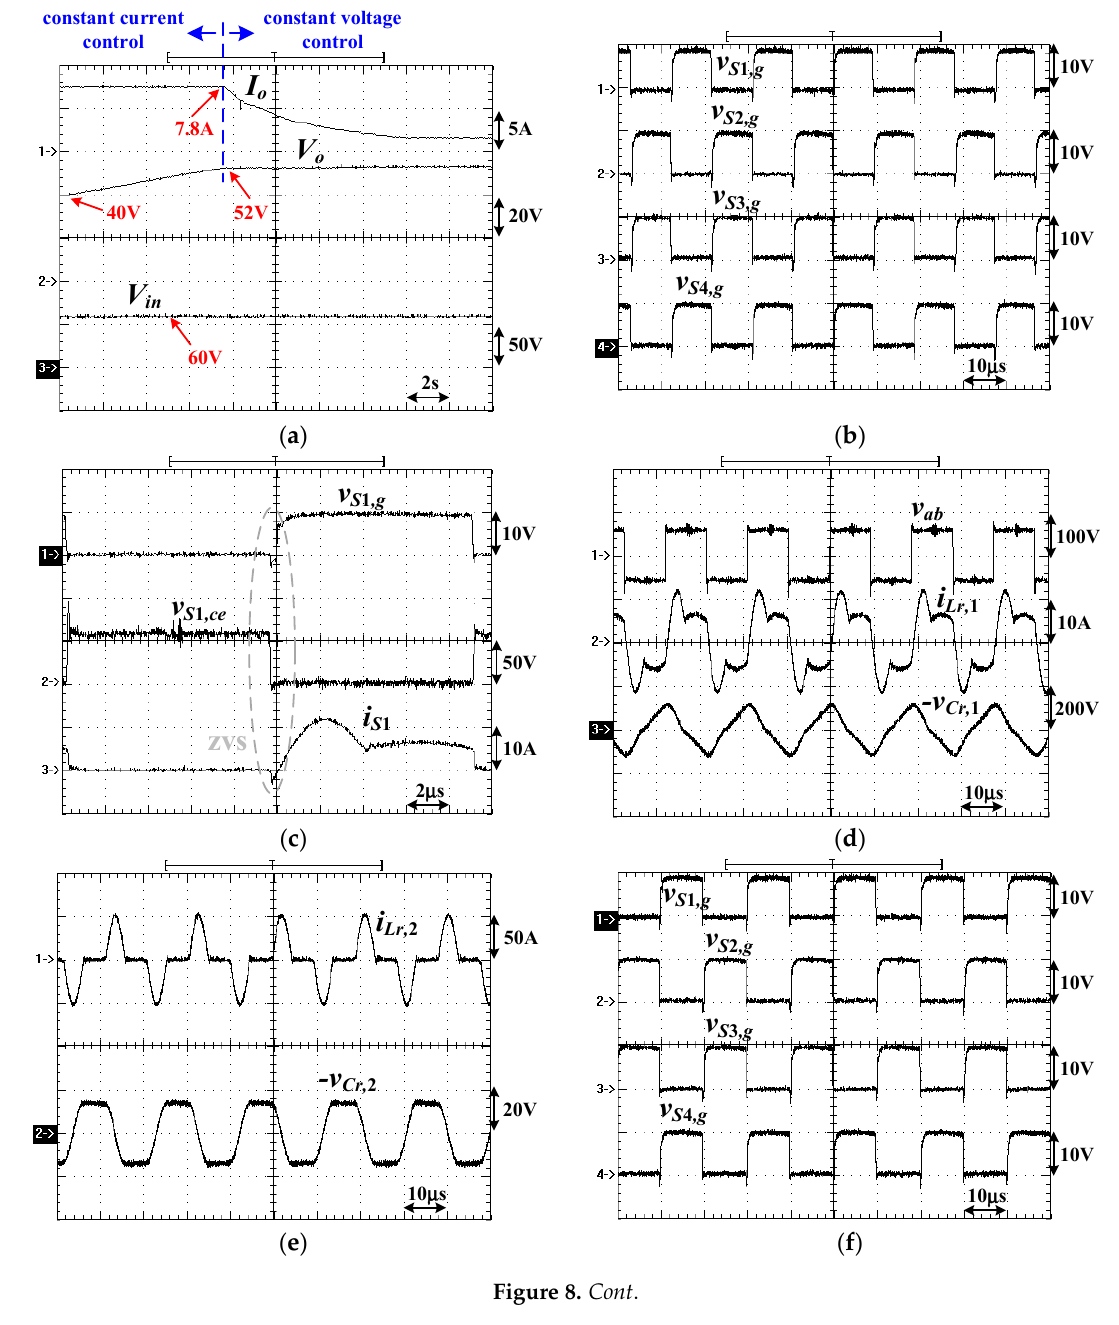
Figure 7. Measured waveforms of V in , S ac 1 , and S ac 2 .